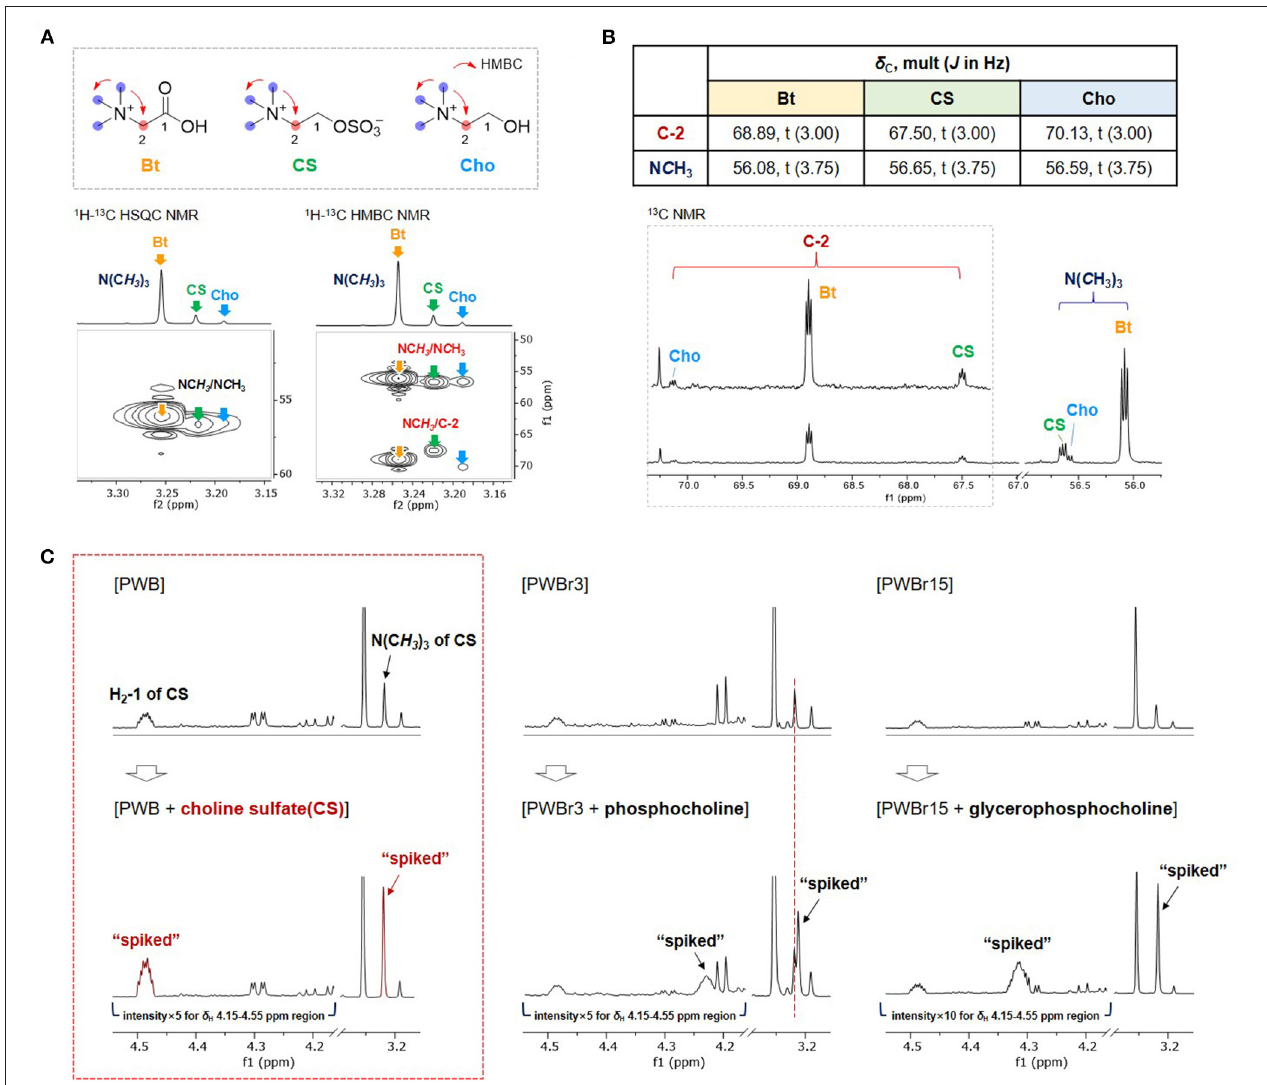
FIGURE 2 | Comparison of (A) 1 H- 13 C HSQC and HMBC correlations and (B) 13 C NMR signals of C-2 and N C H 3 of betaine (Bt), choline sulfate (CS), and choline (Cho) in PWB. (C) Spiking 1 H NMR experiments with commercial standards of CS, phosphocholine, and glycerophosphocholine.